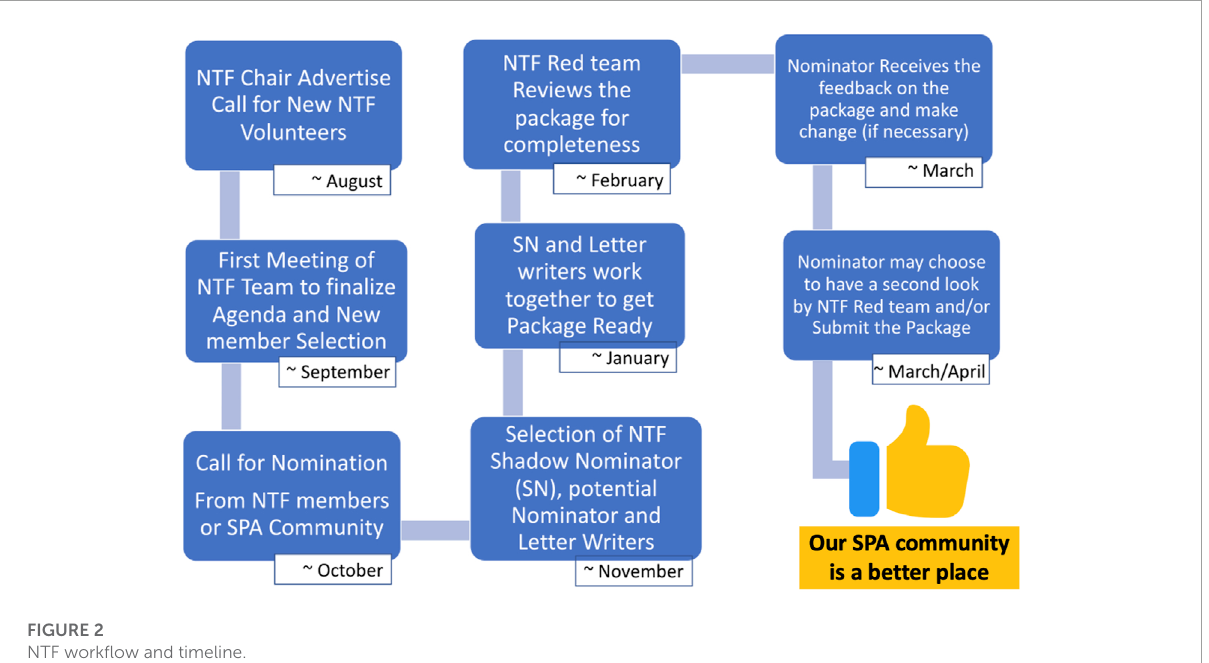
FIGURE 2 NTF workflow and